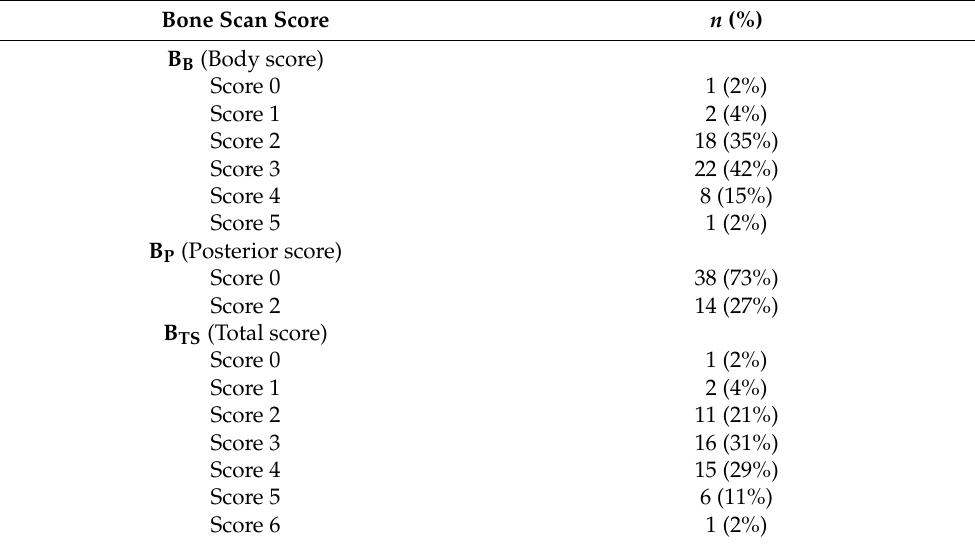
Table 2. Bone scan scoring system results for included patients ( n =